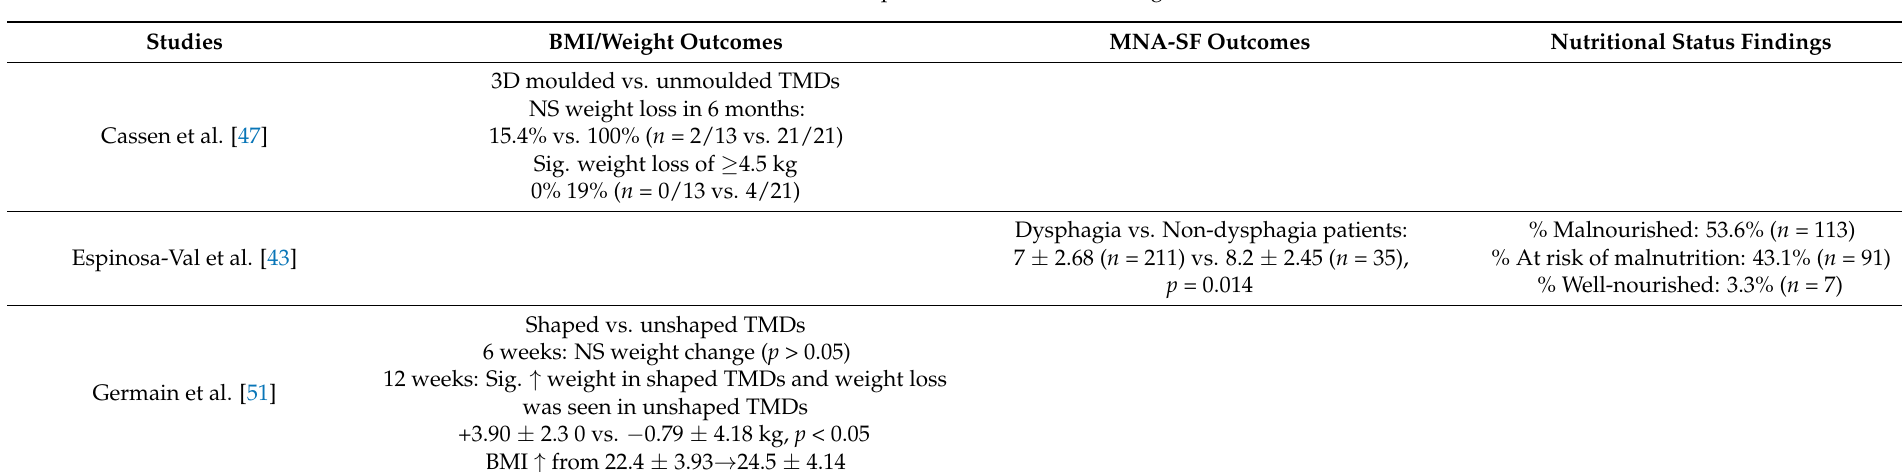
Table 3. Outcome data for experimental studies assessing nutritional